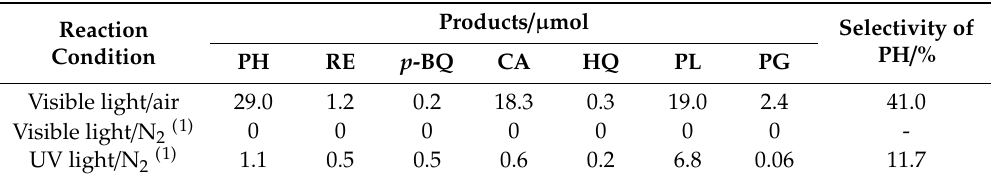
Table 2. E ff ects of Ag + ions added on the photocatalytic hydroxylation of benzene on the Pt(0.2)-WO 3 photocatalyst under photo-irradiation.